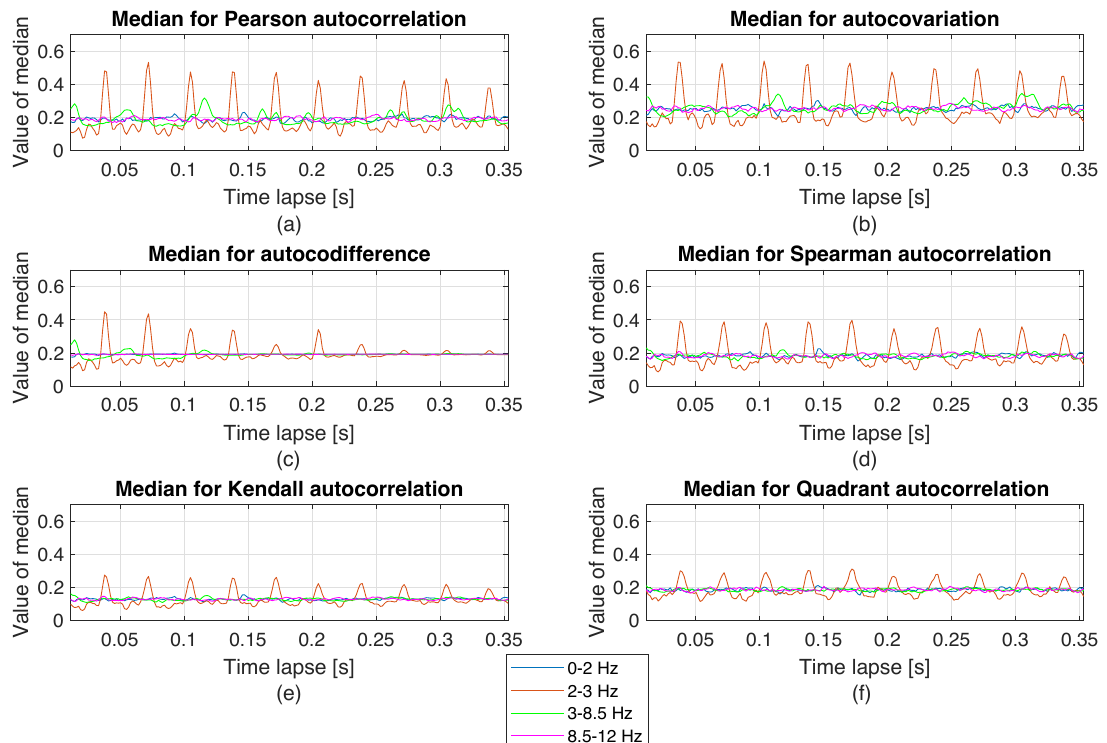
Figure 6. Comparison of medians for different frequency bands: 0–2 kHZ (Gaussian white noise), 2–3 kHz (informative frequency band), 3–8.5 kHz (heavy-tailed noise), and 8.5–12 kHz (Gaussian white noise), in the case of different measures of dependence: ( a ) Pearson autocorrelation, ( b ) autocovariation, ( c ) autocodifference, ( d ) Spearman autocorrelation, ( e ) Kendall autocorrelation, ( f ) Quadrant